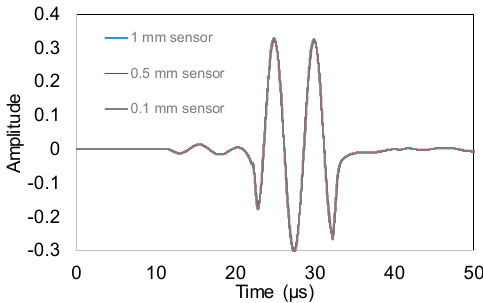
Figure 16. Simulated waveforms received by different size sensors from surface source with excitation frequency equal to 500 kHz (curves overlap).